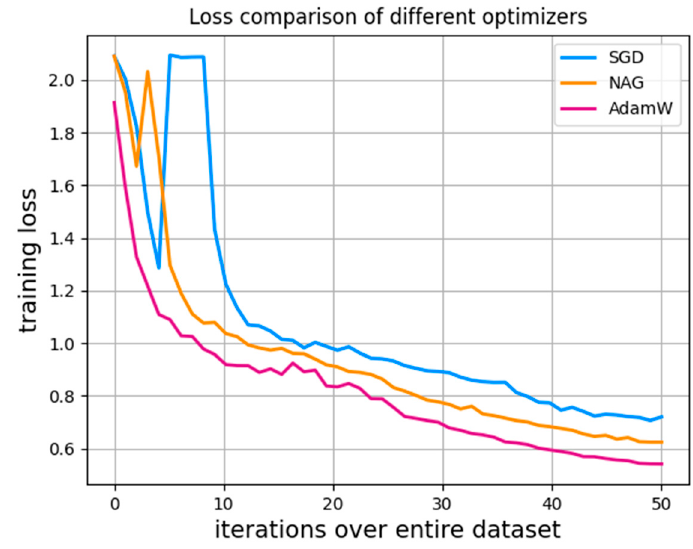
Figure 15. The convergence process of different optimizers. Table 4. Comparison of accuracy of different optimizers.